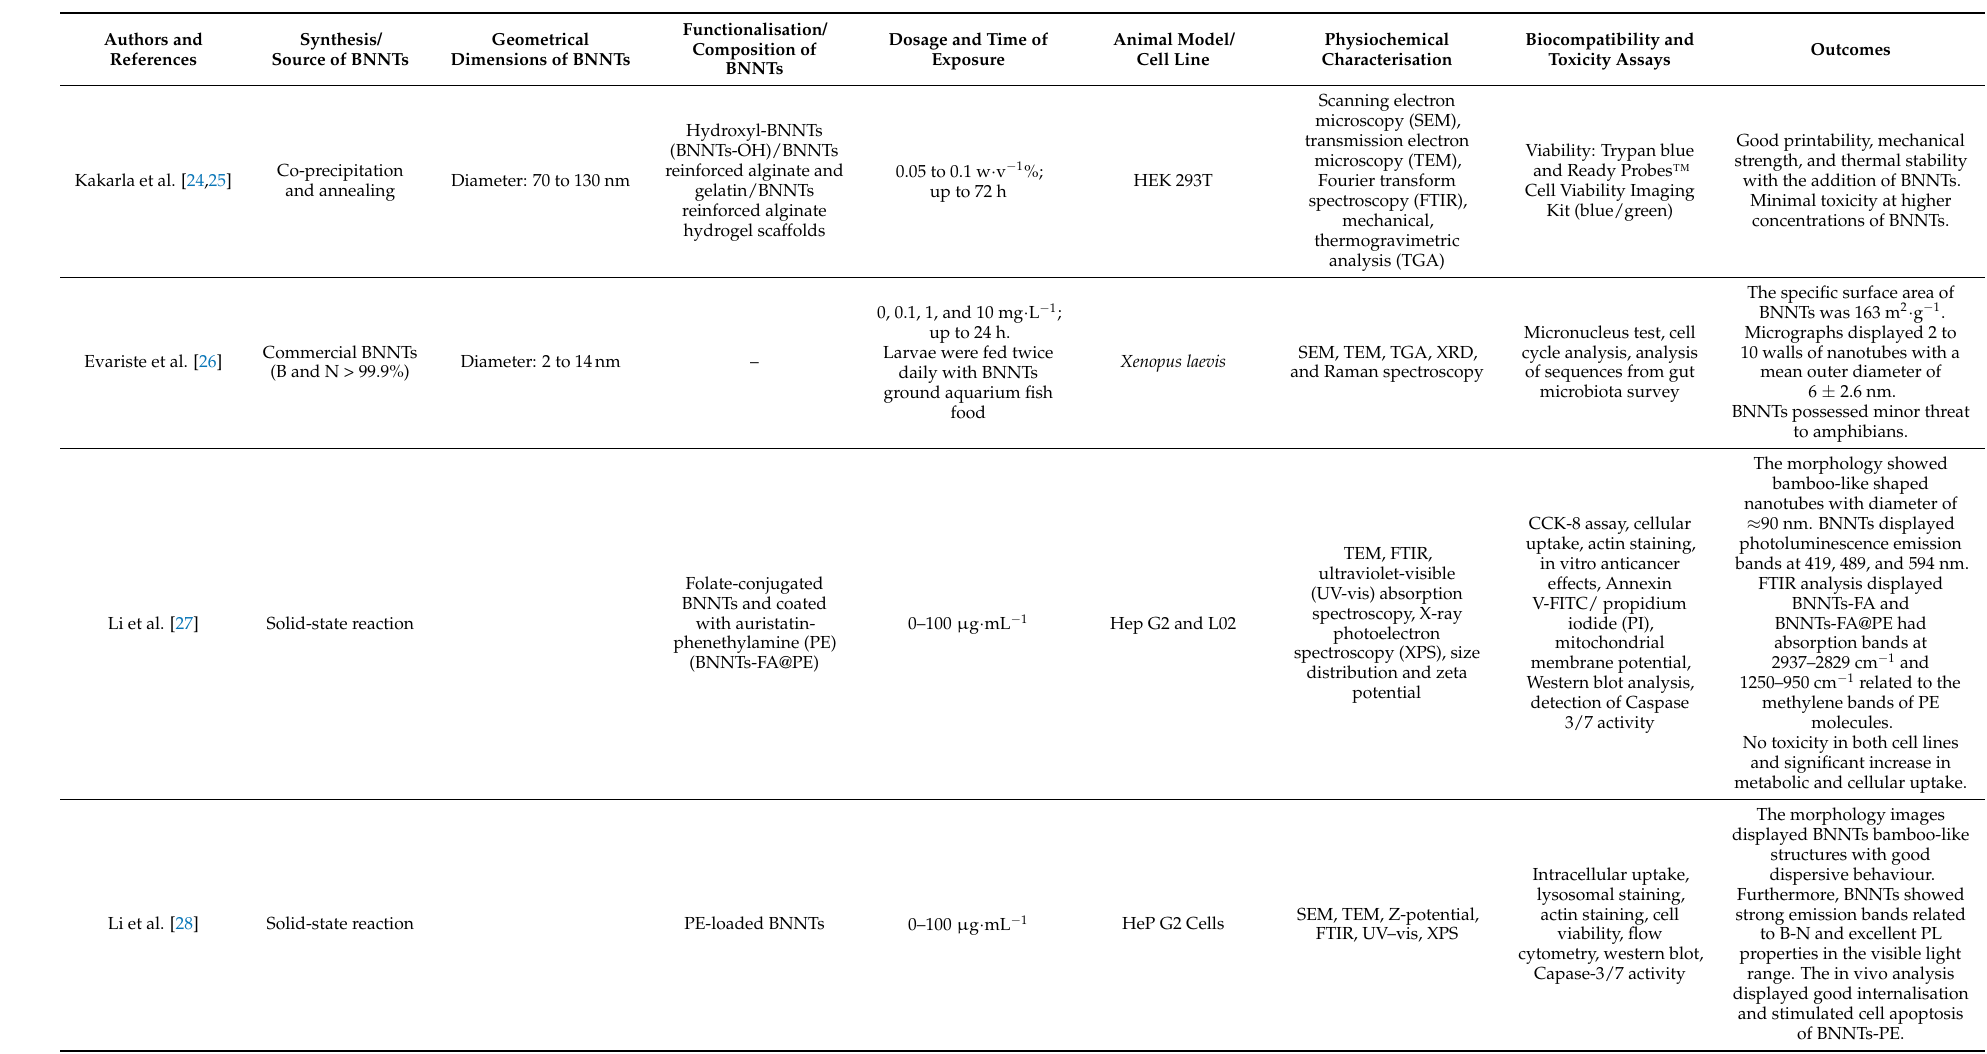
Table 2. Summarised correlation between BNNTs geometry, functionalisation, dosage, and time of exposure on various cells and their